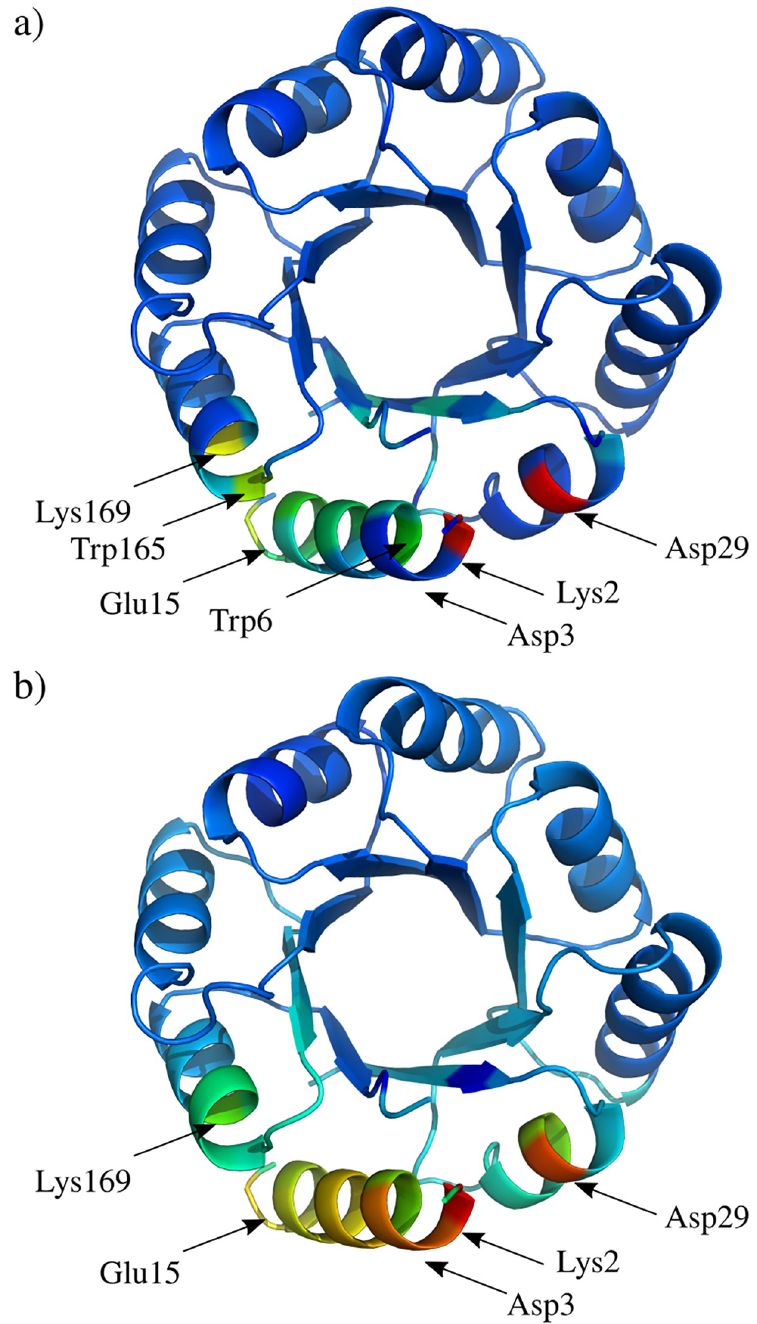
Fig 3. Network Differential Analysis (NDA). The protein structure coloured to represent the magnitude of the centrality for each residuum. The PyMOL colour palette rainbow is used (red colour for high centrality, blue for low values). In a) D C E tot is shown and in b) we show D C eff results. Selected high scoring residues are labelled. k k